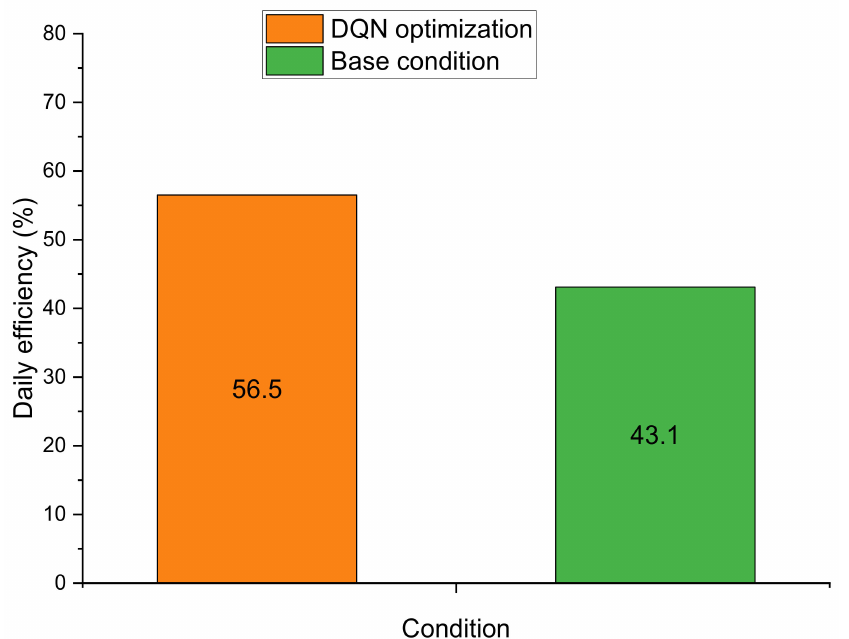
Figure 6. The daily efficiency of the solar still with nanofluids optimized using DQN and the solar still with water.